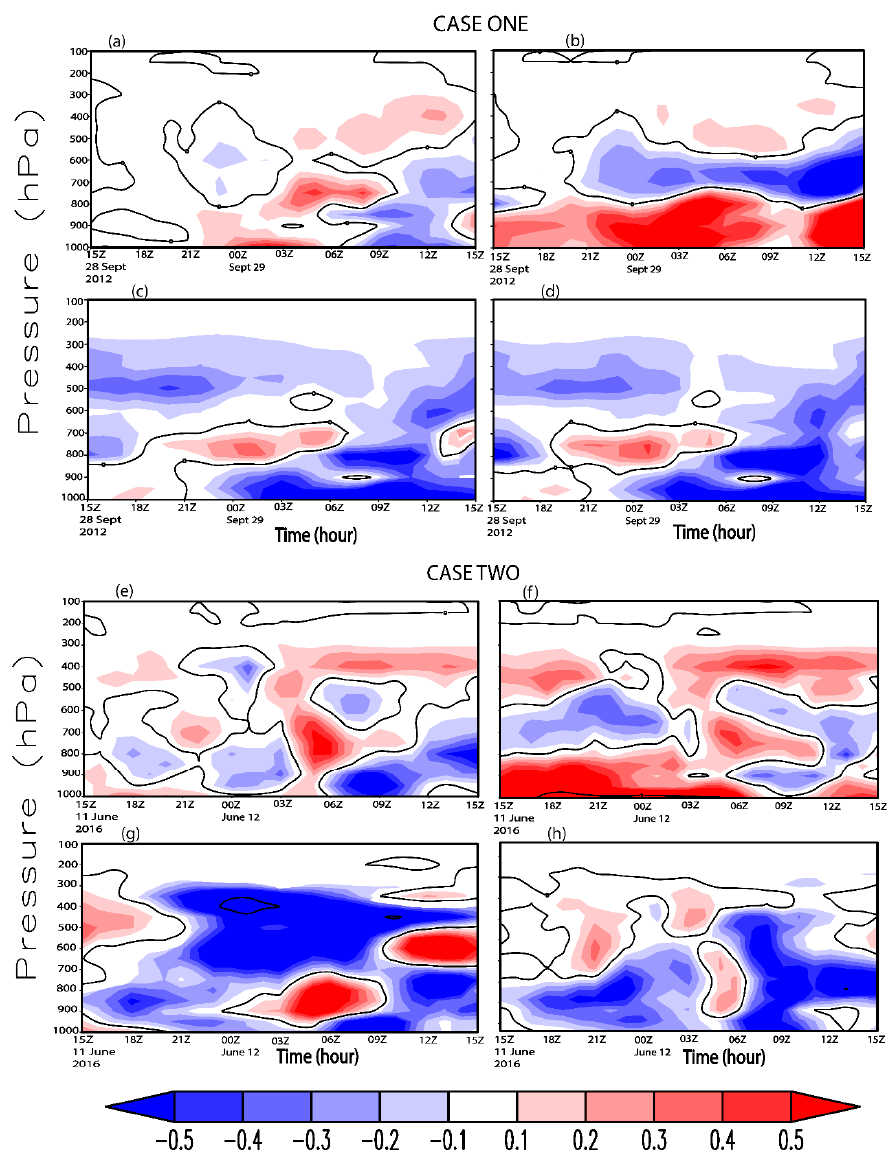
Figure 7. Pressure-time cross sections of the di ff erences in water vapor (g / kg) between CASE